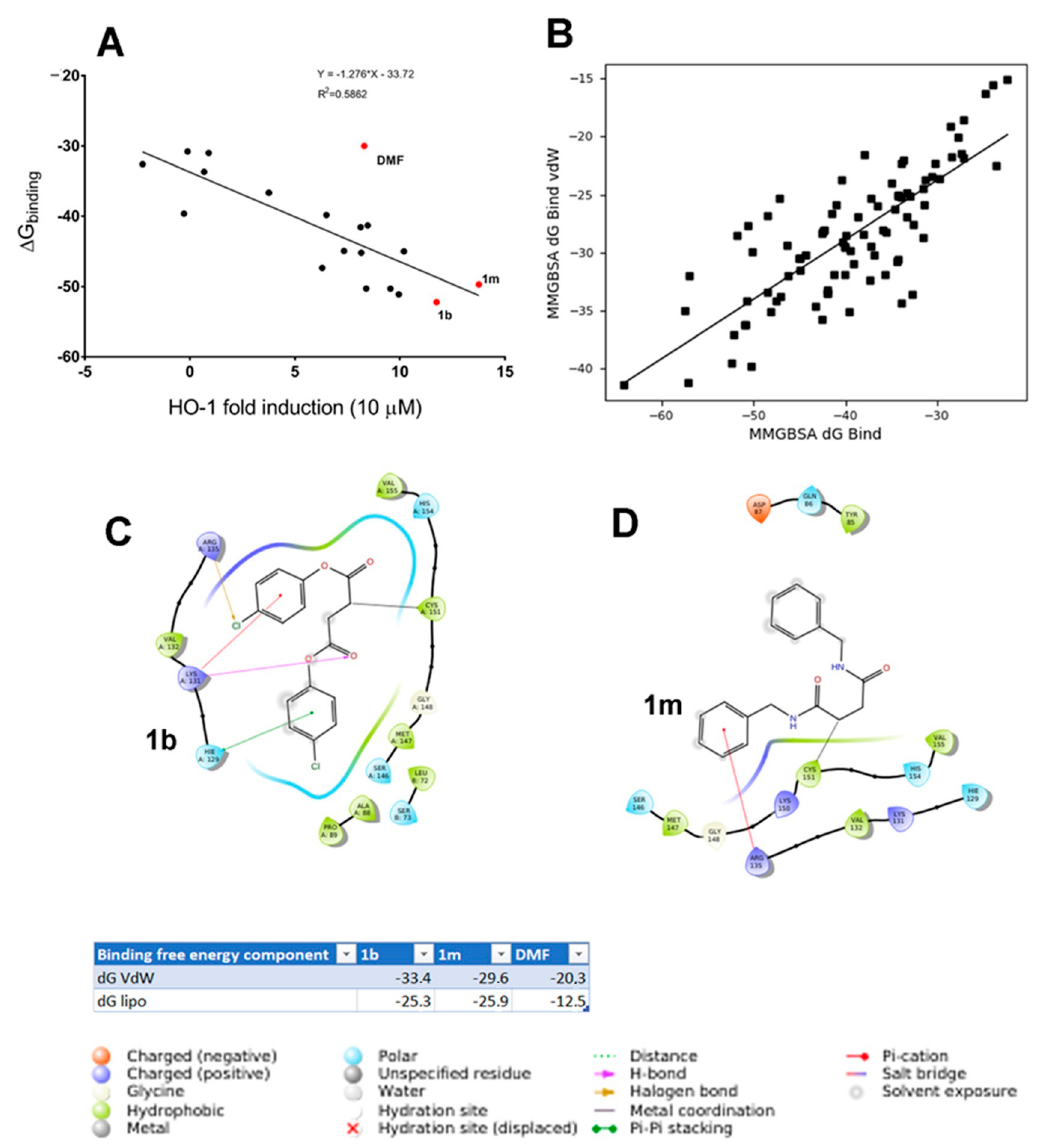
Figure 2. Results of computational studies. ( A ) Correlation of experimental results with predicted binding free energy; ( B ) correlation of predicted binding free energy versus Van der Waal component; ( C ) pose of compound 1b at Kelch-like ECH-associated repressor protein 1 (Keap1); ( D ) pose of compound 1m at Keap1.